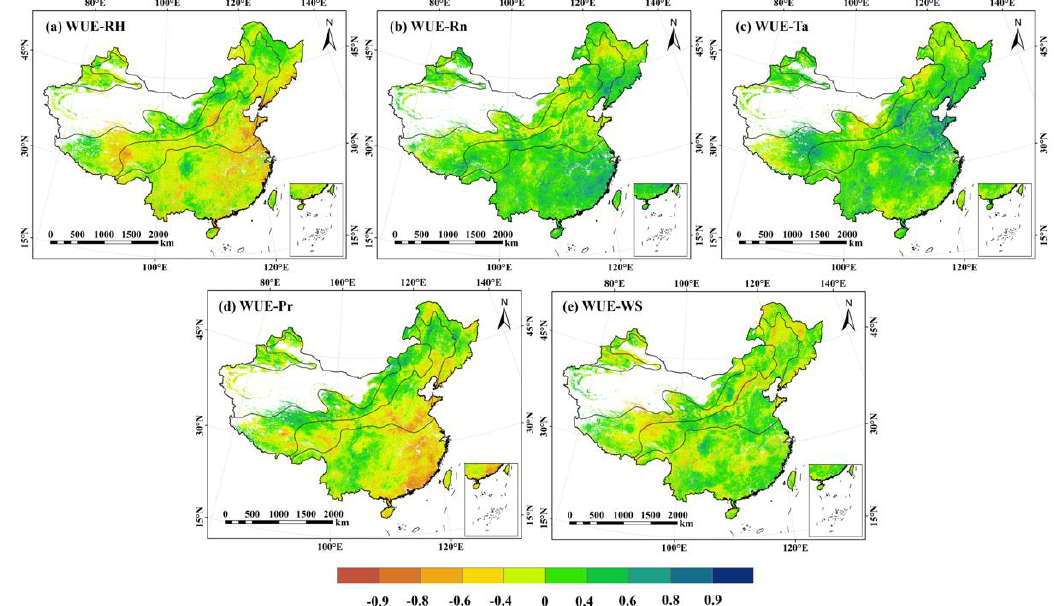
Figure 10. Spatial distribution of correlation coefficients ( − 1~1, unitless) between WUE and climatic factors from 2001 to 2021. ( a ) Relative Humidity (RH); ( b ) Net radiation (Rn); ( c ) Average temperature (Ta); ( d ) Precipitation (Pr); ( e ) Wind Speed (WS).